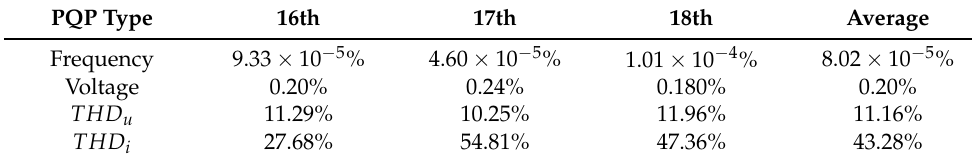
Table 10. Forecasting error (MAPE in%) for 16–18 August 2021, when using PQLR. PQP Type